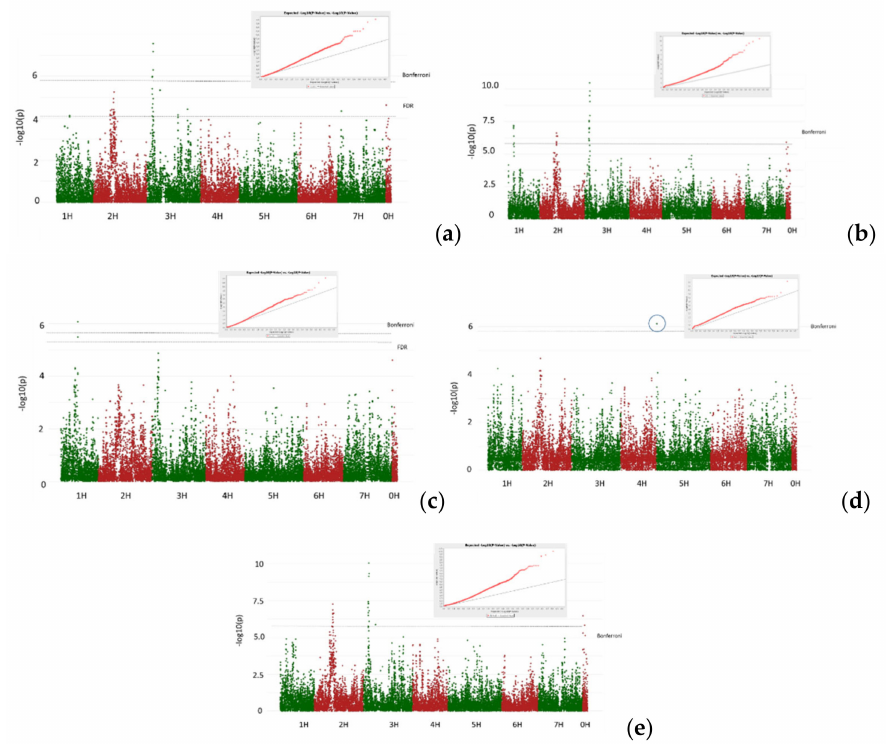
Figure A2. Manhatten plots QQ plots for GLM + Q model for: ( a ) O18.2 seedling, ( b ) Ch3 seedling, ( c ) Kh2 seedling, ( d ) Ch3 adult, ( e ) first